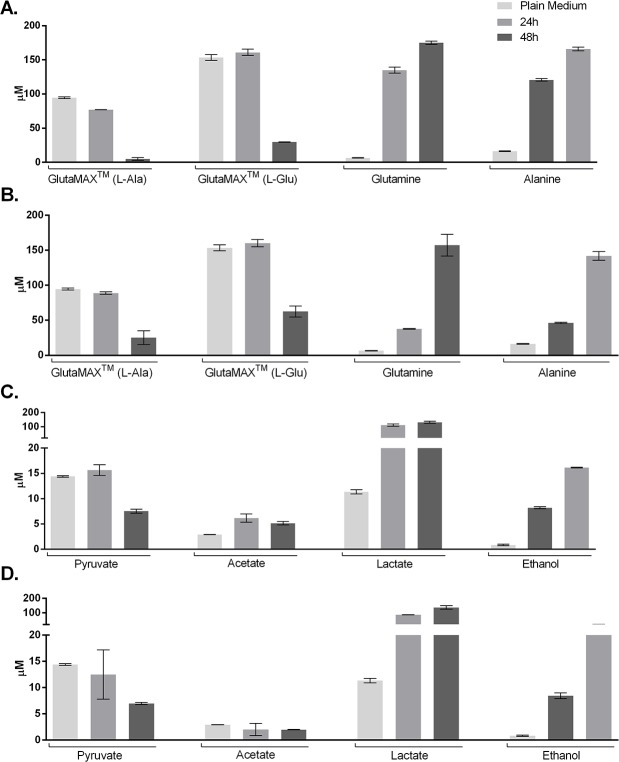
Metabolite dynamics.Dynamics of GlutaMAXTM breakdown to glutamine and alanine of UC-MSCs (A) and DPSCs (B) populations; and Dynamics of Pyruvate catabolism into acetate, lactate and ethanol of UC-MSCs (C) and DPSCs (D) populations. Statistical significance of observed differences available in S1 Table, as Supporting Information.